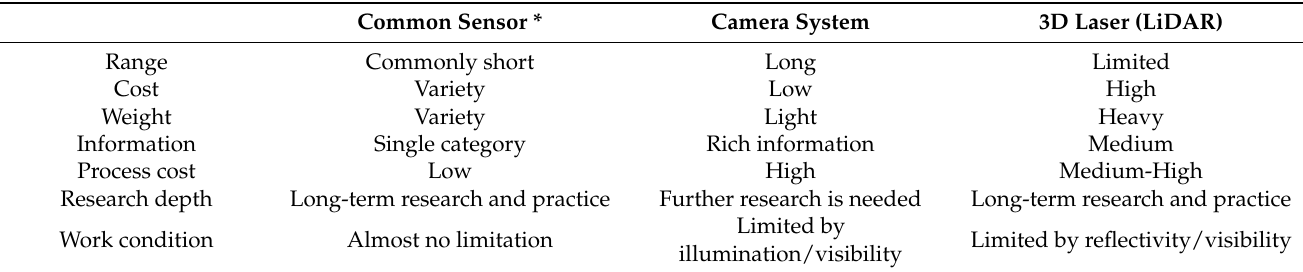
Table 9. Advantages and limitations of cameras, common sensors, and 3D